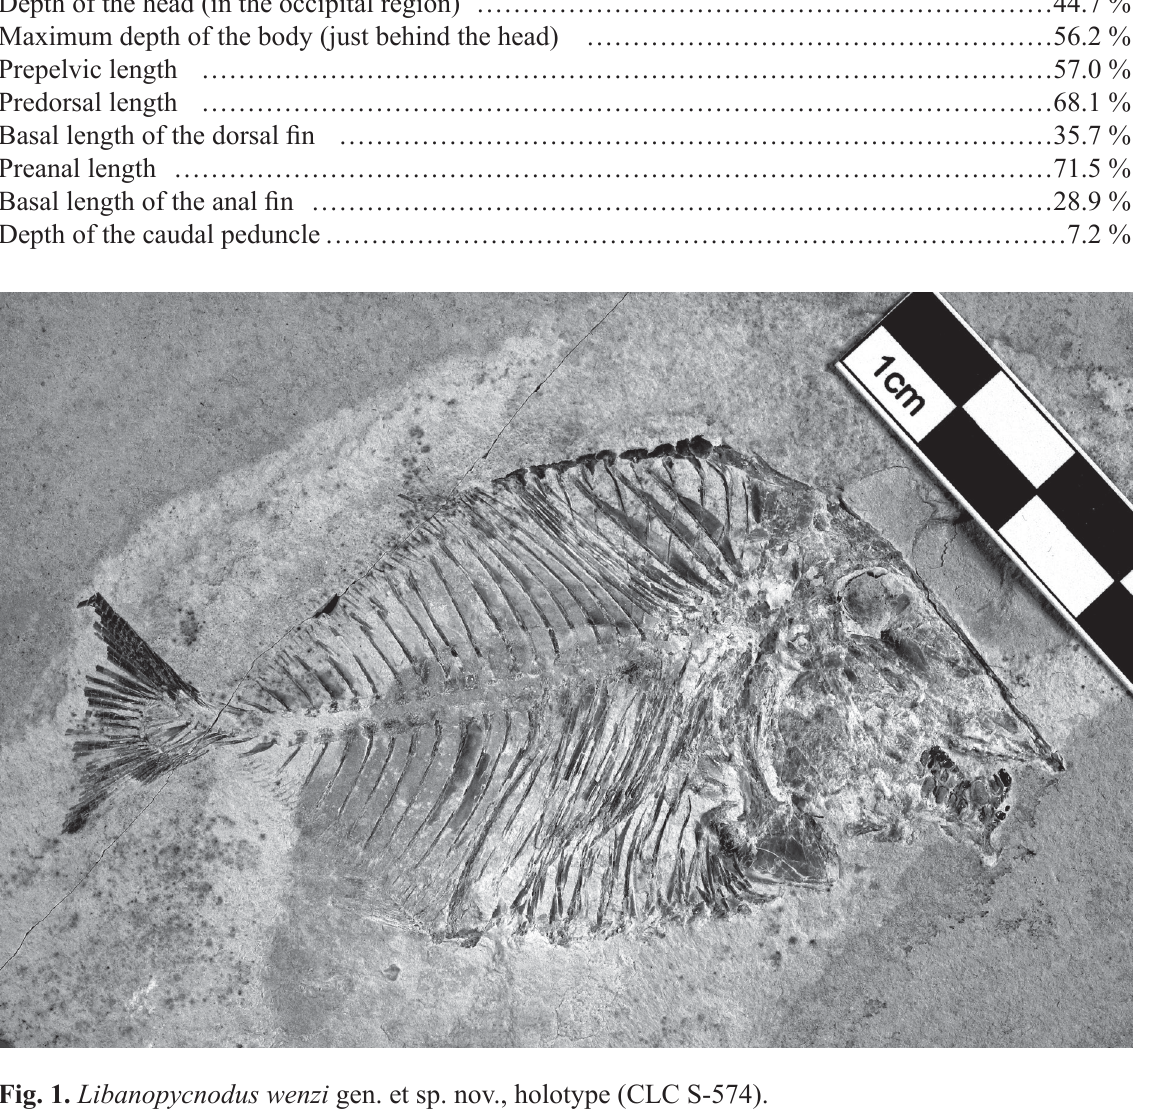
Fig. 1. Libanopycnodus wenzi gen. et sp. nov., holotype